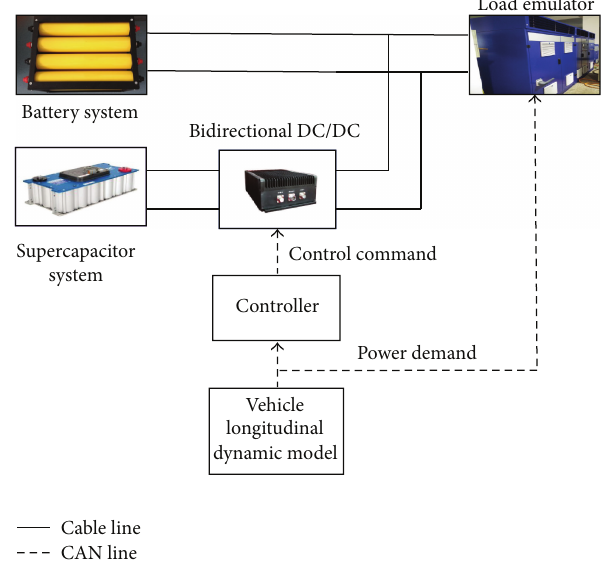
Figure 4: Another type of semiactive topological structures.